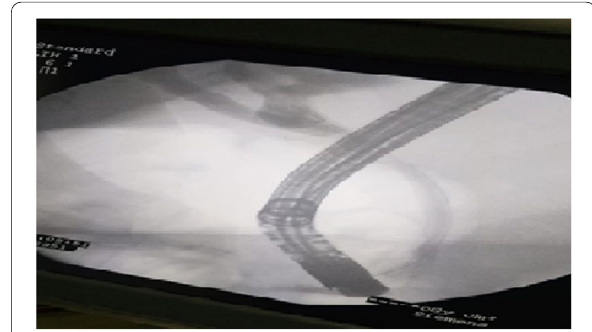
Fig. 1 Selective CBD cannulation with cholangiogram revealing dilated CBD and proximal biliary radicles with small distal stricture